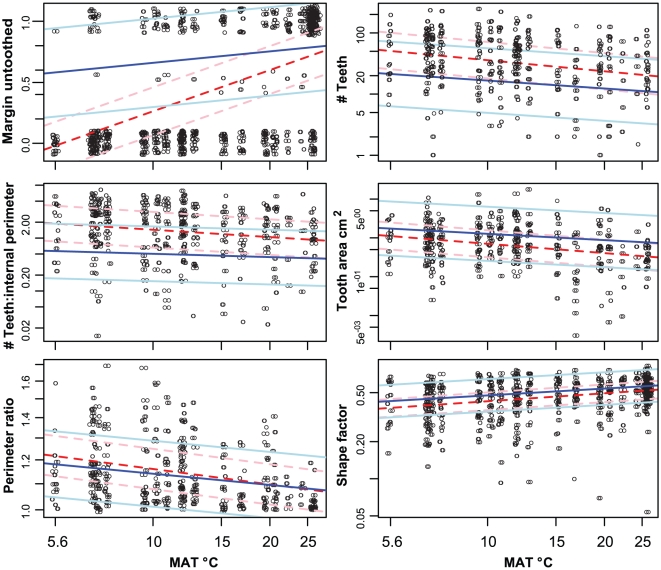
Mean annual temperature versus leaf traits.Mean annual temperature (MAT) versus the six leaf traits featured in Figure 2 of Royer et al.
[12]. For each trait, the best-fit lines for nonphylogenetic GLS (dashed line) and phylogenetic GLS (solid line) are displayed. All traits except Margin untoothed and MAT were log10-transformed. Phylogenetic models used branch lengths scaled by the best-fit estimate of Pagel's λ parameter [51] (Table 1). A 95% confidence interval is displayed for each regression model (dashed rose lines  =  nonphylogenetic GLS, solid blue lines  =  phylogenetic GLS) to illustrate the increased uncertainty in predictions of climate from leaf traits when phylogeny is taken into account. Points were lightly jittered at each site to better visualize density of trait values.